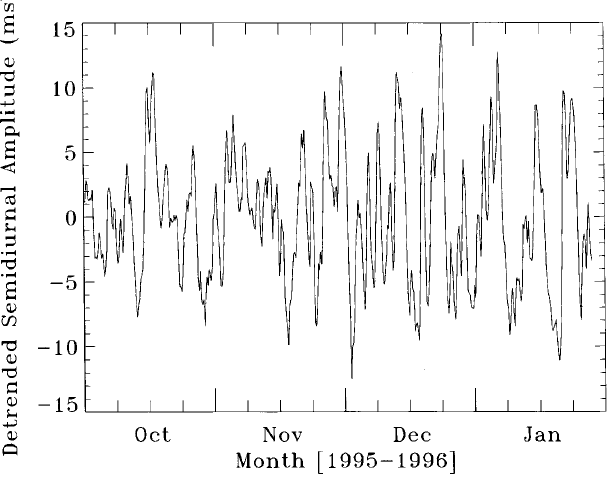
Fig. 5. Time-series of detrended amplitudes of the coherent semidi- urnal oscillation during October 1995–January 1996. This time-series was formed by first sequentially fitting 24-h blocks of data, every 6 h and in each azimuth direction, with a 12-h sinusoid. The time-series of semidiurnal oscillations in each direction were detrended and then vector averaged to obtain the coherent semidiurnal oscillation present in all four measurement